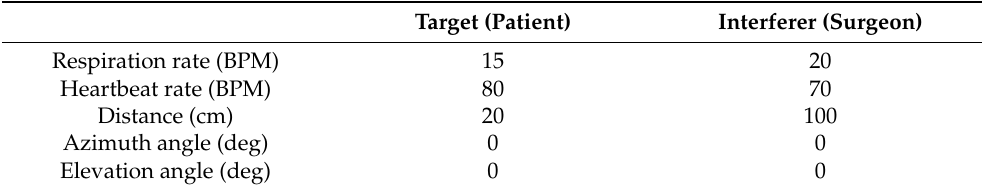
Table 1. Simulation information with interferer in a different range.